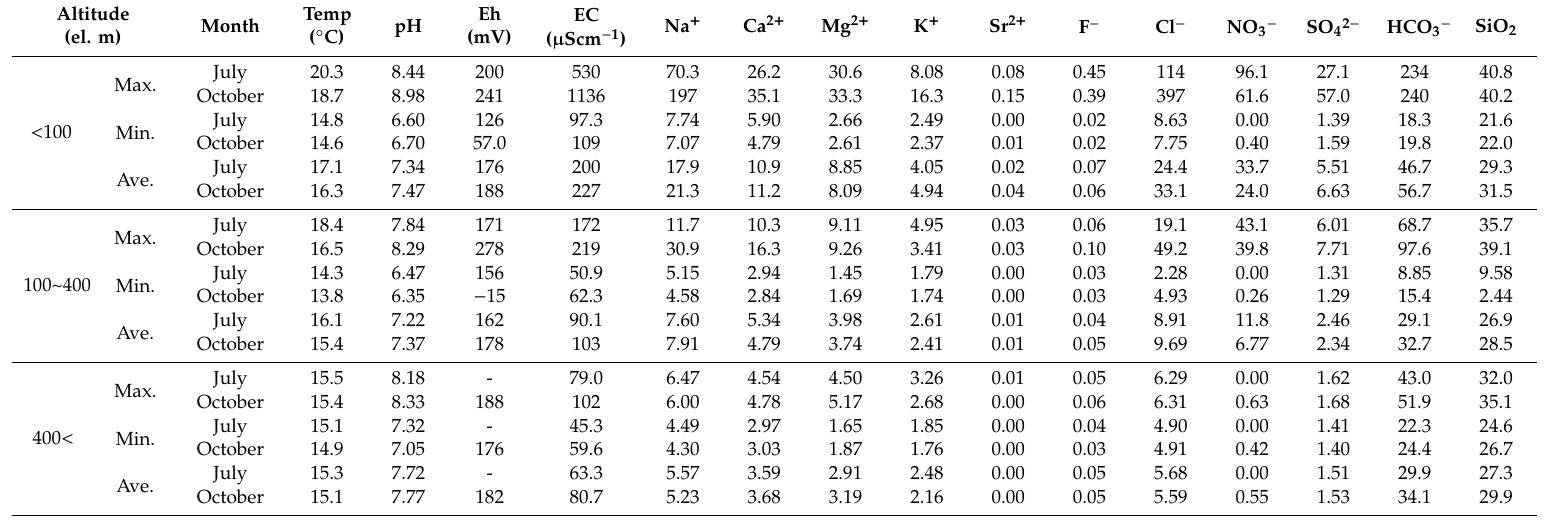
Table 1. Statistical data of chemical compositions of groundwater samples according to the altitude in Jeju Island (Unit: mg / L). Altitude (el. m)